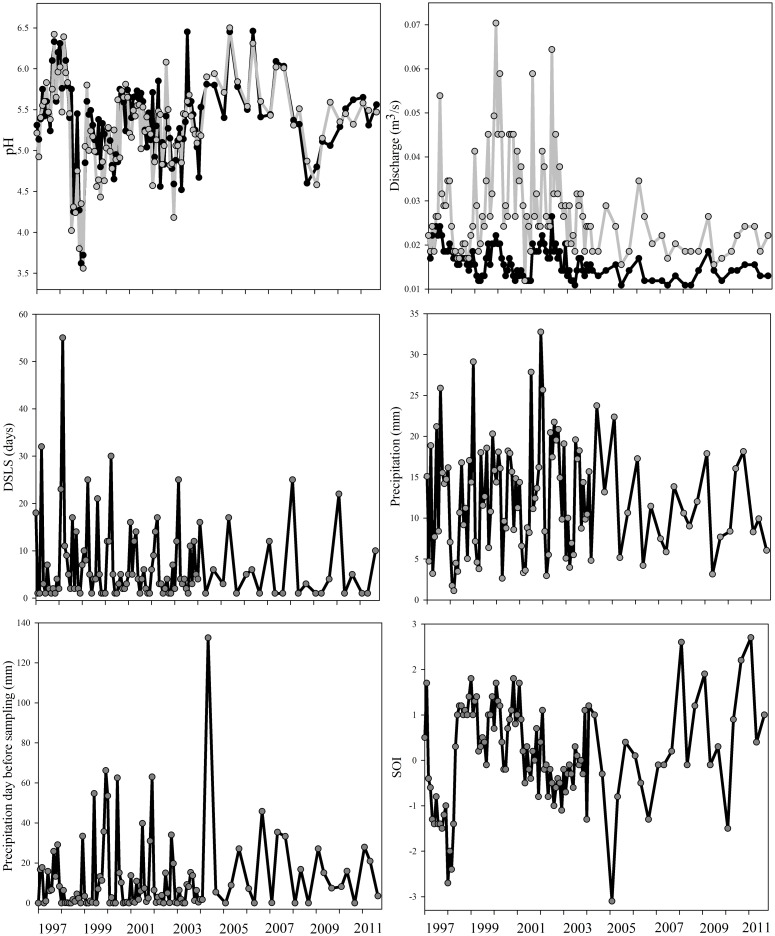
Monthly temporal patterns of climate and environmental variables between 1997 to 2011 in Carapa-60 (Black line) and Saltito-100 (Gray line).Last four graphs show overall patterns for both streams.